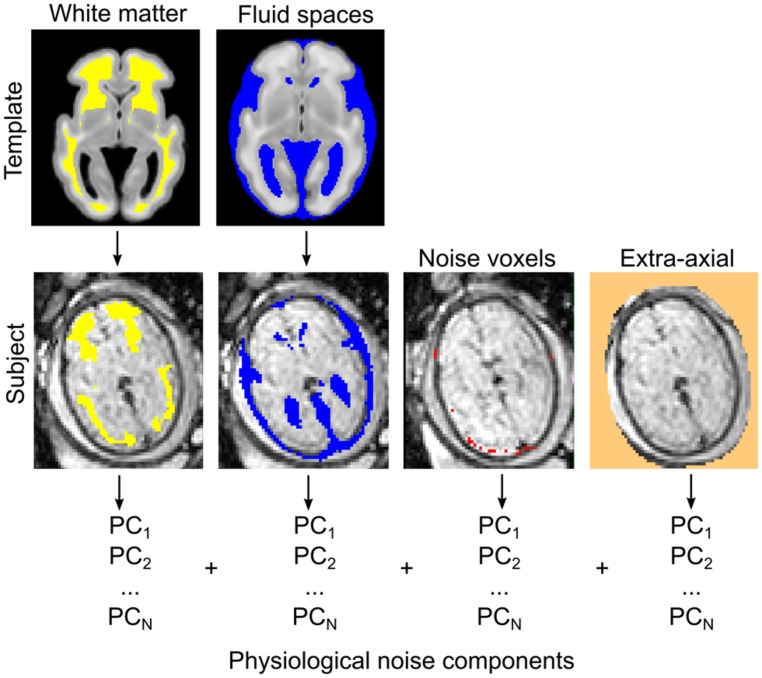
Estimating physiological noise components for the correction of fetal fMRI signal using an adaptation of the CompCor approach. Top row: white matter and CSF components are segmented from the GW-specific anatomical templates. Segmentations are transformed to individual subjects (bottom row) while the voxels with highest temporal variation, and other, extra-axial structures, are calculated from the data. These voxels are used to perform the component-based filtering of the nuisance signal, according to the CompCor method described by Behzadi et al. (2007). PCs, principal components.